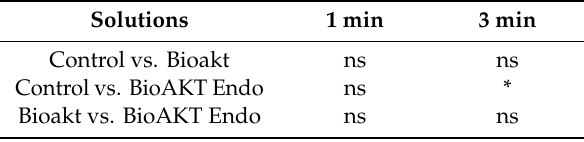
Table 5. E ff ect of the tested solutions on dead cell ratio (C.L.S.M. assay)